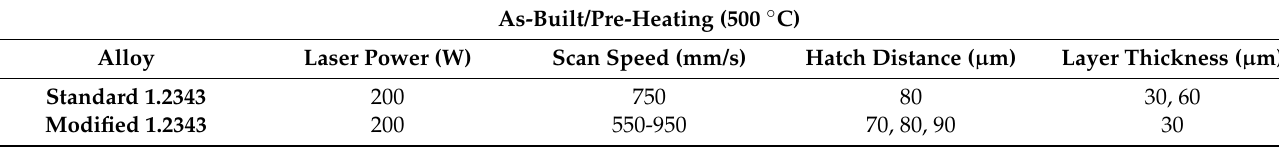
Table 2. The process parameter design.